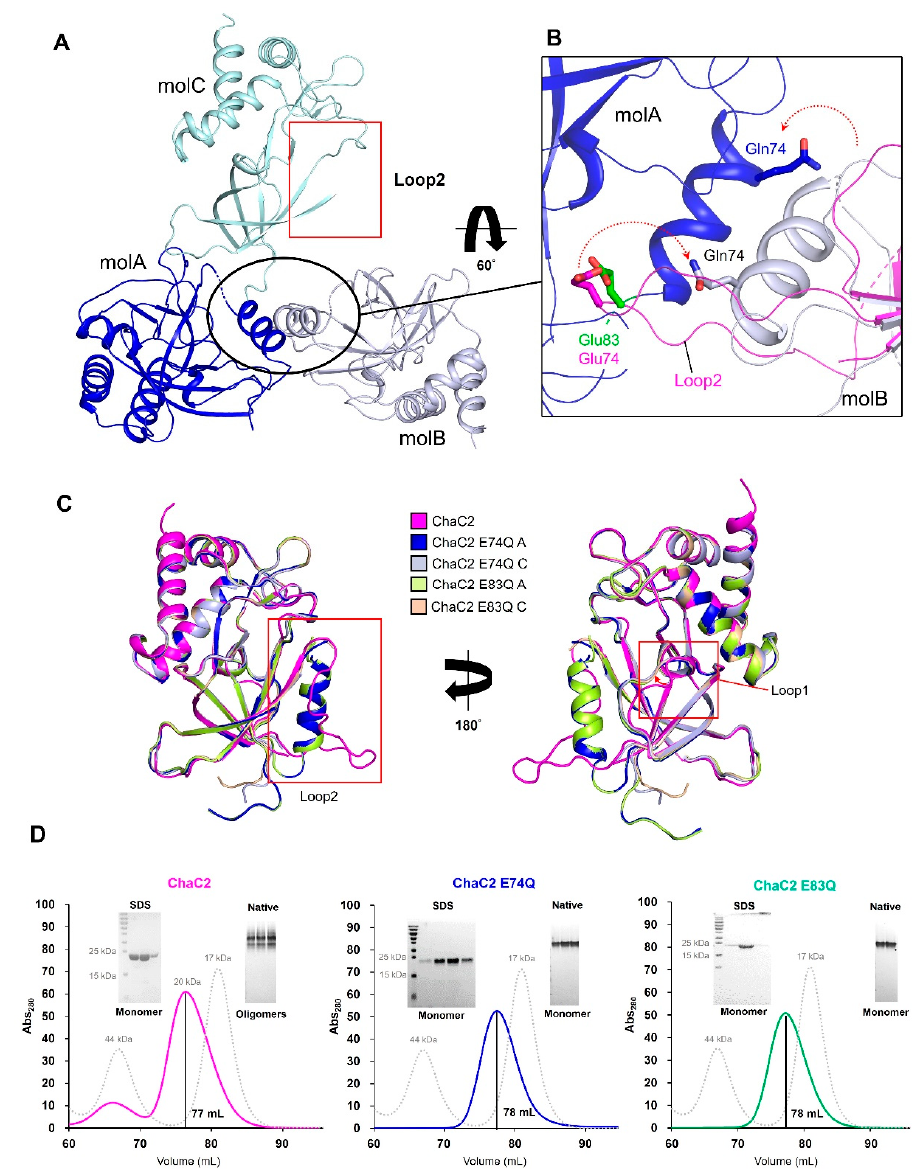
Figure 4. Conformation changes of ChaC2 E74Q and ChaC2 E83Q mutants. ( A ) Structures of the ChaC2 E74Q mutant. Three ChaC2 E74Q molecules (mol) in an ASU are denoted in blue (molA), white blue (molB), and pale cyan (molC), respectively. The loop2 region of molC is marked by a red circle. ( B ) Newly formed helices on the interface of ChaC2 E74Q molA and molB superimpose to the loop2 region of the ChaC2 monomer. Side chains of Gln74 and Glu83 of ChaC2 E74Q molA and molB are represented as stick models. The Glu83 of ChaC2 E74Q molA and Glu74 of ChaC2 monomer are colored in green and magenta, respectively. The Gln74 of ChaC2 E74Q molA and molB are colored in blue and white blue, respectively ( C ) Superimposition of ChaC2 and its mutants. The structure of ChaC2 (magenta), ChaC2 E74Q (blue and light blue), and ChaC2 E83Q (green and wheat) showing the different conformations of loop2 (left) and loop1 (right) are superimposed. Loop2 and loop1 are donated with red boxes. ( D ) Size-exclusion chromatograms for ChaC2 (pink line), ChaC2 E74Q (blue line), and ChaC2 E83Q (green line). ChaC2 (20 kDa), ChaC2 E74Q, ChaC2 E83Q, and calibrants were loaded onto a HiLoad Superdex 75 pg column at a flow rate of 1 mL/min. The eluted proteins were monitored at 280 nm. The chromatogram of the calibration mixture (ovalbumin 44 kDa and myoglobin 17 kDa) are shown in gray. The SDS-PAGE and native-PAGE gel of the main peak protein fractions are shown beside the